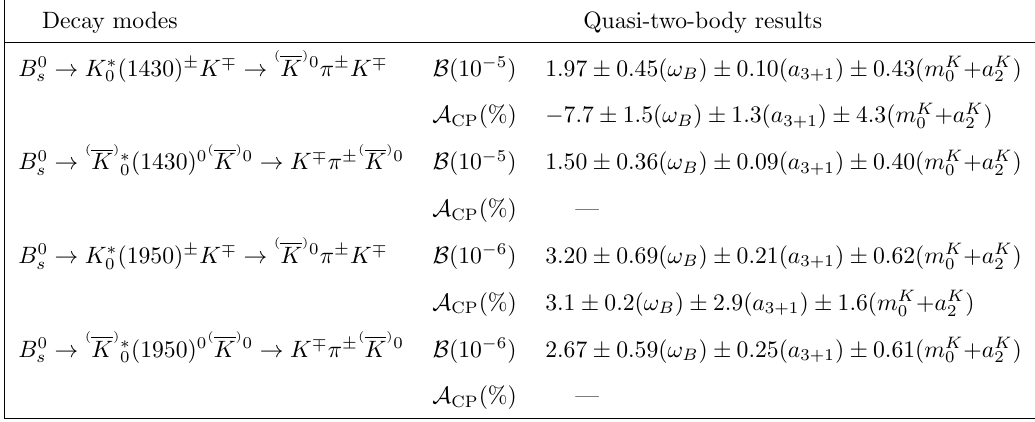
(1430) and K (cid:3) (1950) as the 0 0